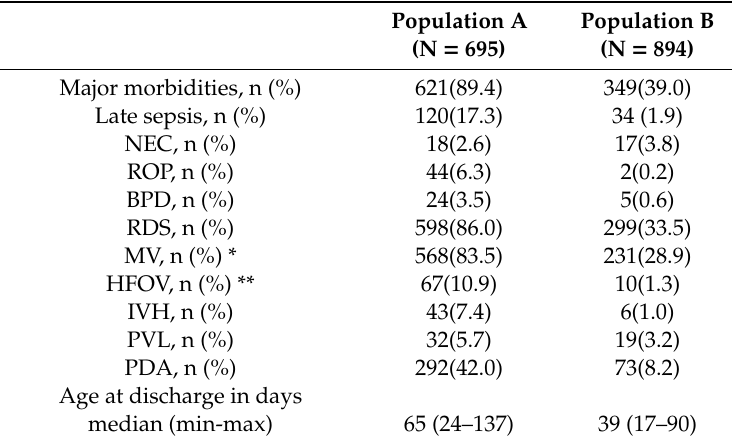
Table 2. Major morbidities during hospital